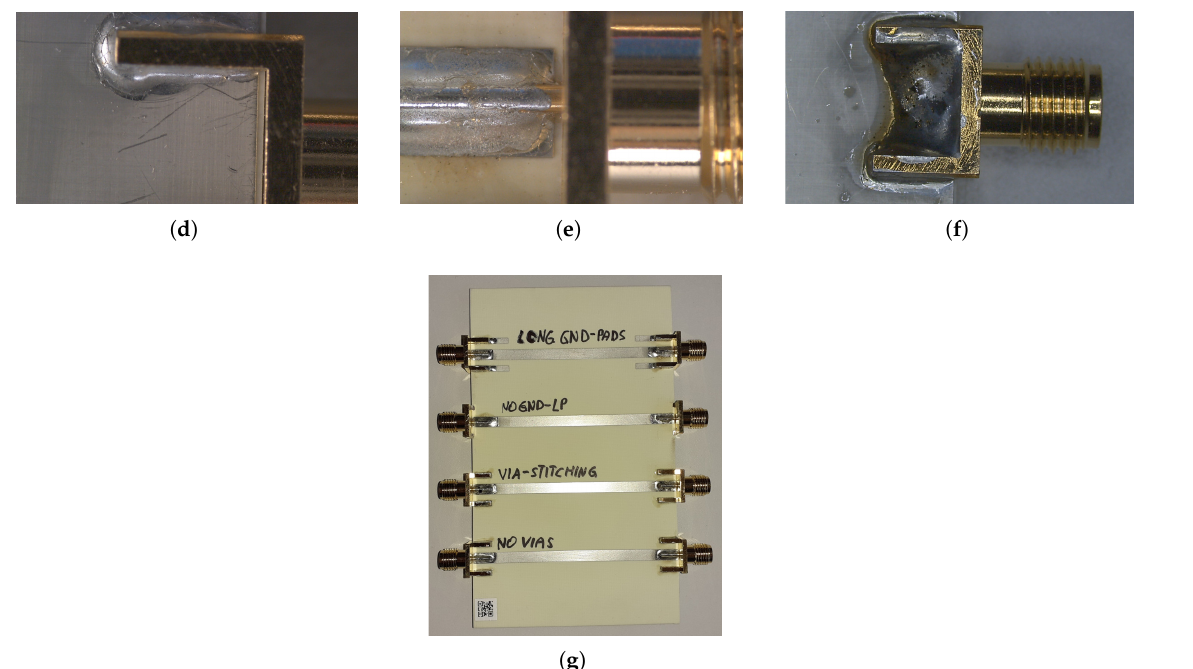
Figure 1. ( a ) Test PCB 1 and PCB 4. ( b ) Test PCB 2. ( c ) Test PCB 3. ( d , e ) Test PCB 1, PCB 2, PCB 3 and PCB 4 top and bottom view with 150 µ m ground edge. ( f ) Solder at the bottom layer to connect the bottom ground metal with the SMA connector body. ( g ) Complete PCB design. The PCB is connected via coaxial cables to the VNA Keysight PNA-X N5244B.